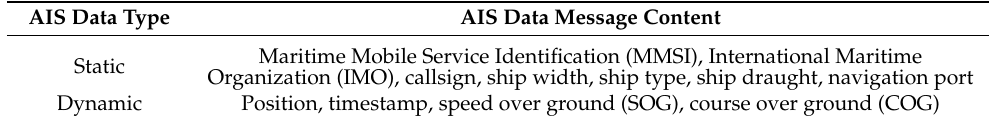
Table 1. AIS data message